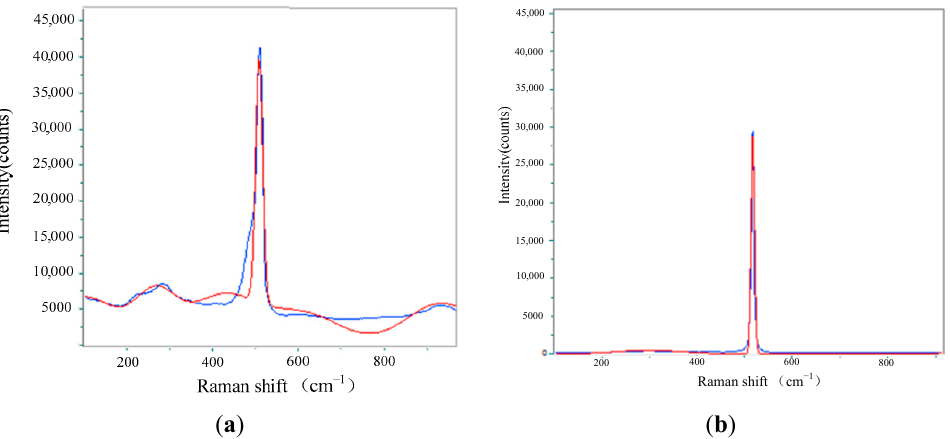
Figure 6. Gaussian peak fitting diagram of Raman spectra of disordered SiNWs. ( a ) Before annealing. ( b ) After annealing.